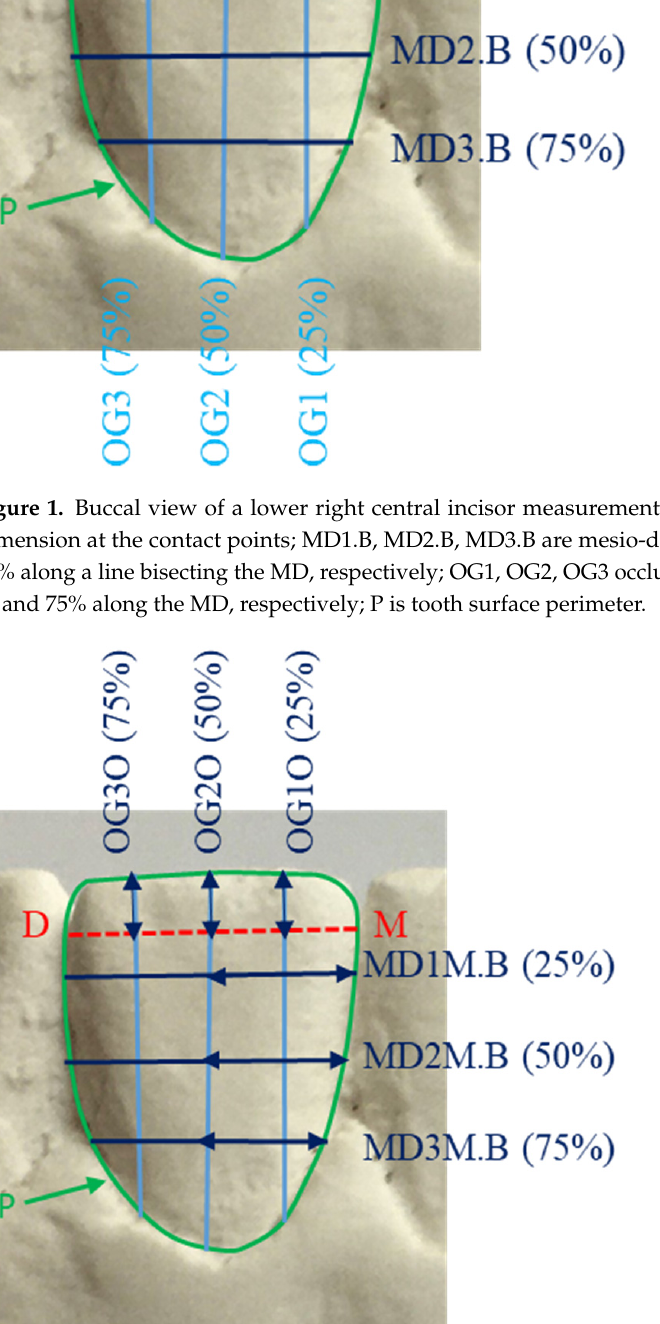
Figure 2. Buccal view of a lower right central incisor partial measurements: MD1M.B, MD2M.B and MD3M.B are the mesial parts of the mesio ‐ distal measurements at 25, 50 and 75% along the OG2, respectively and determined by OG2; OG1O, OG2O and OG3O are the occlusal parts of the occluso ‐ gingival measurements at 25, 50 and 75% along the MD, respectively and determined by the MD.